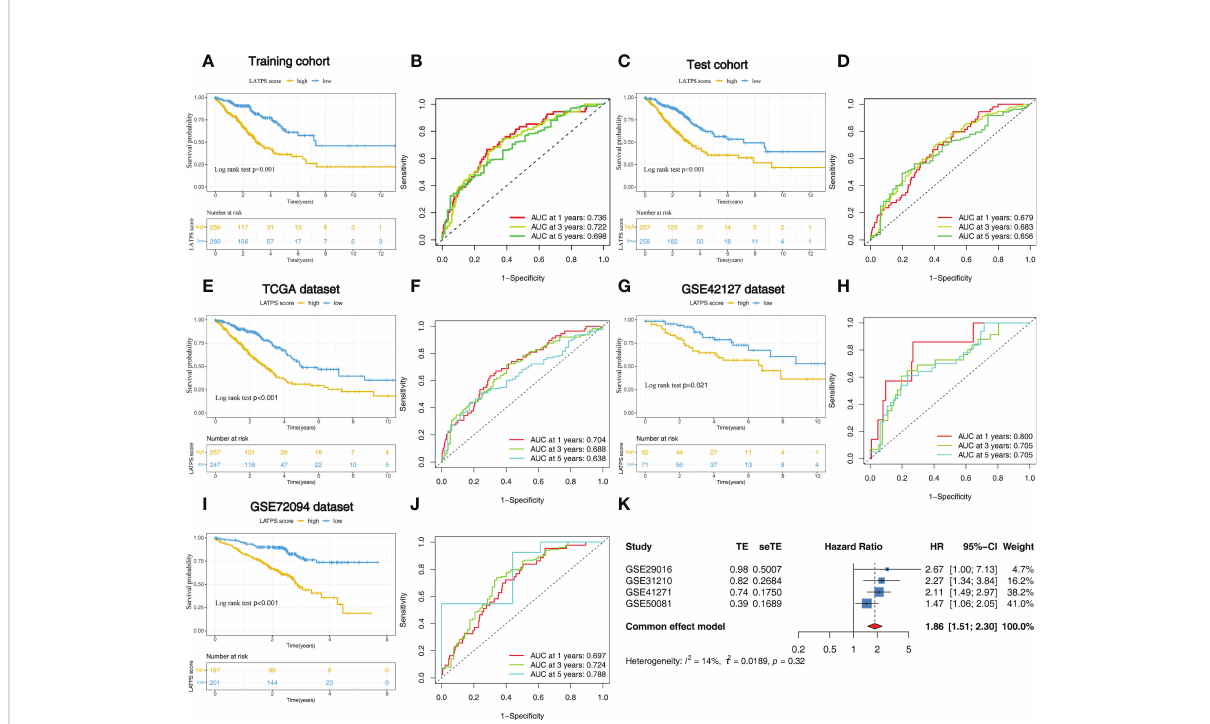
FIGURE 6 Identi fi cation of the LATPS in the training, test, and external validation cohorts. (A, B) Kaplan – Meier curve and the ROC curve for training cohort. (C, D) Kaplan – Meier curve and the ROC curve for test cohort. (E, F) Kaplan – Meier curve and the ROC curve for TCGA dataset. (G, H) Kaplan – Meier curve and the ROC curve for GSE42127 dataset. (I, J) Kaplan – Meier curve and the ROC curve for GSE72094 dataset. (K) Results of the prognostic meta-analysis on the basis of four external LUAD cohorts. LATPS, LUAD tumor microenvironment prognostic signature; ROC, receiver operating characteristic.